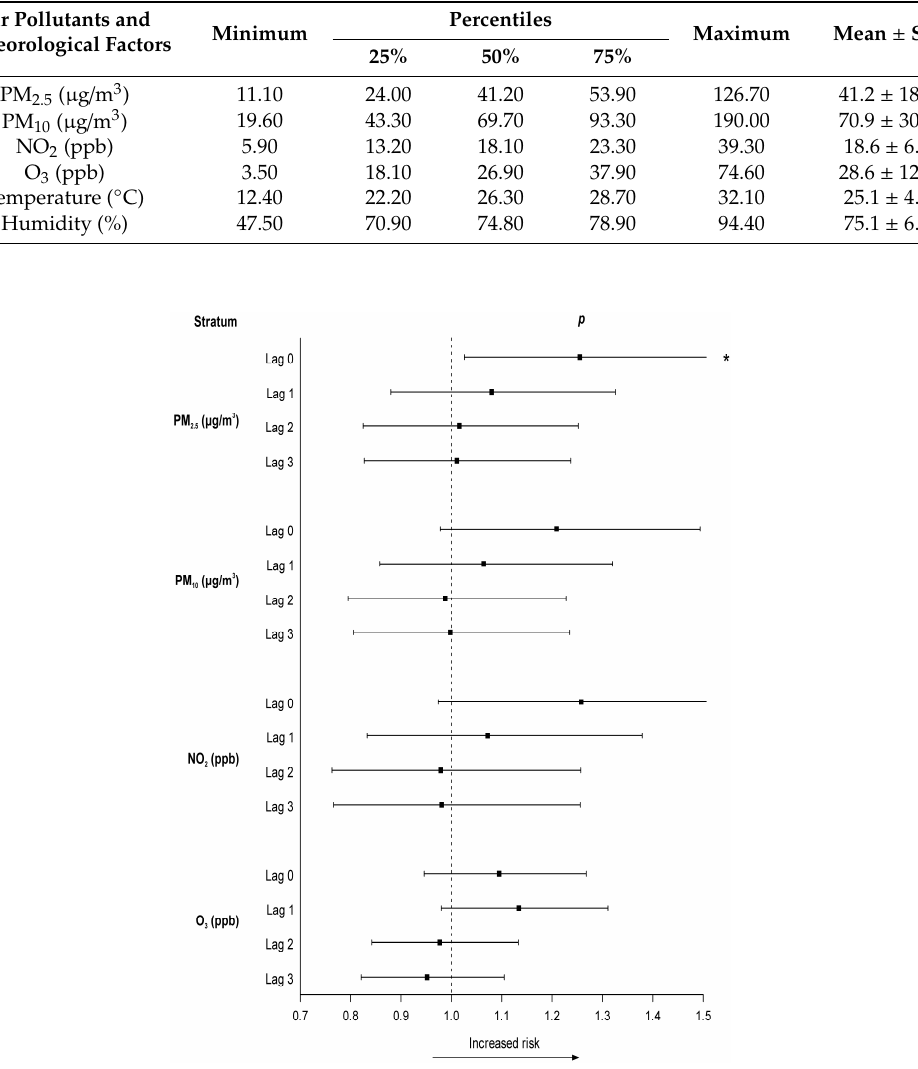
Figure 1. Odds ratio (95% confidence interval) for emergency department visits with ST-segment elevation myocardial infarction, associated with the interquartile range increase in air pollutants. Adjustments were made for temperature and humidity. PM: Particulate matter.